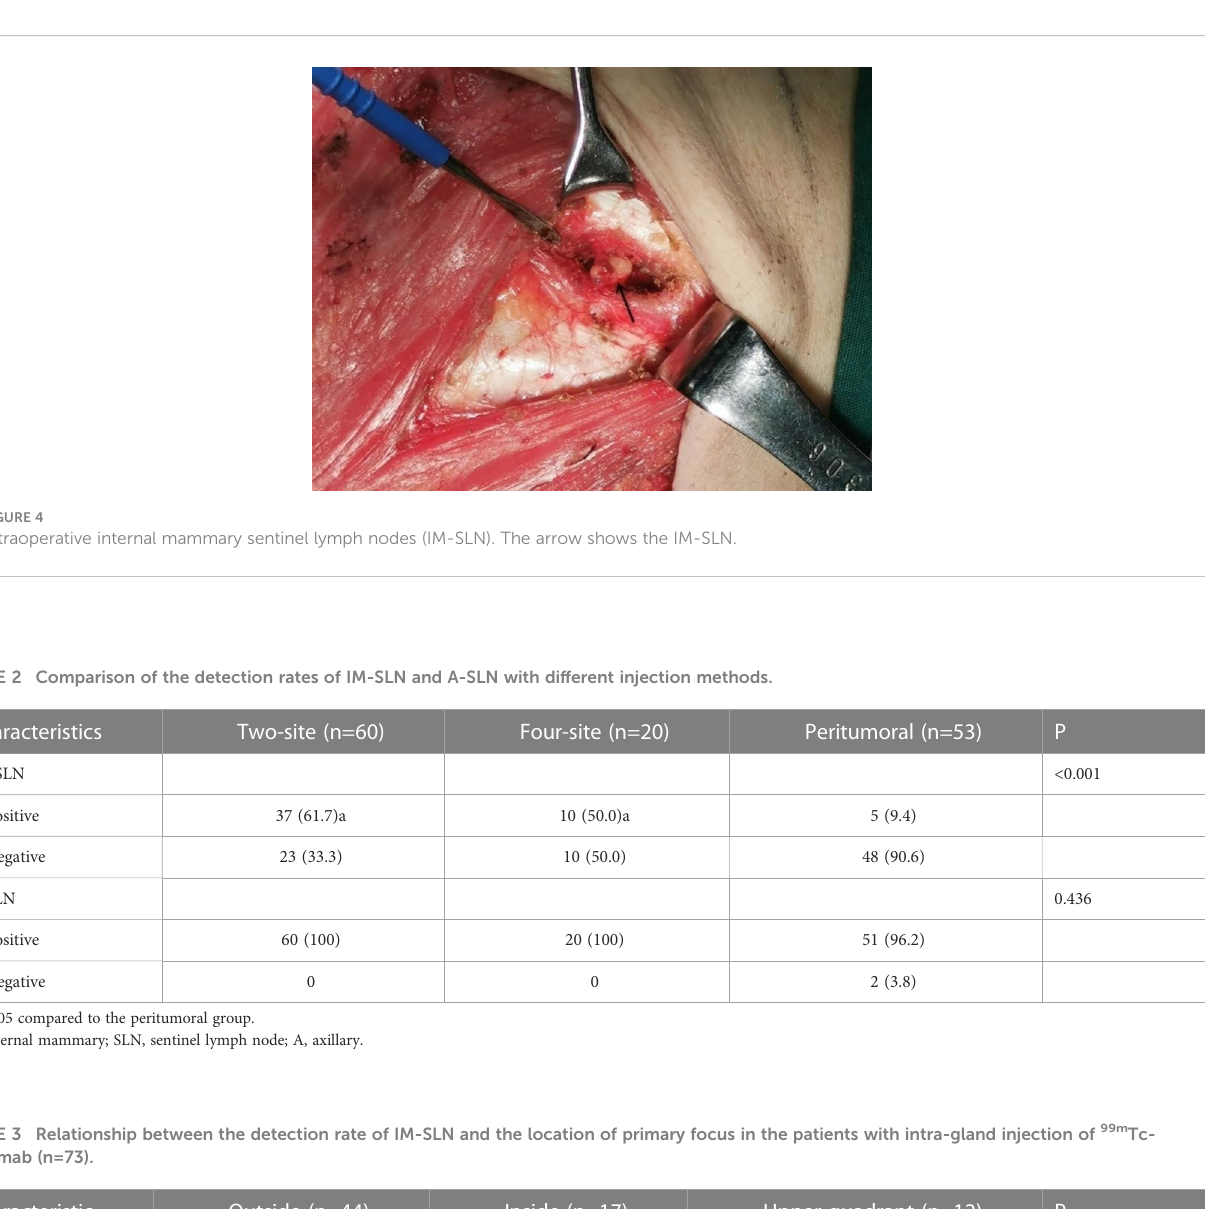
TABLE 3 Relationship between the detection rate of IM-SLN and the location of primary focus in the patients with intra-gland injection of 99m Tc- rituximab (n=73). Characteristic Outside (n=44) Inside (n=17)